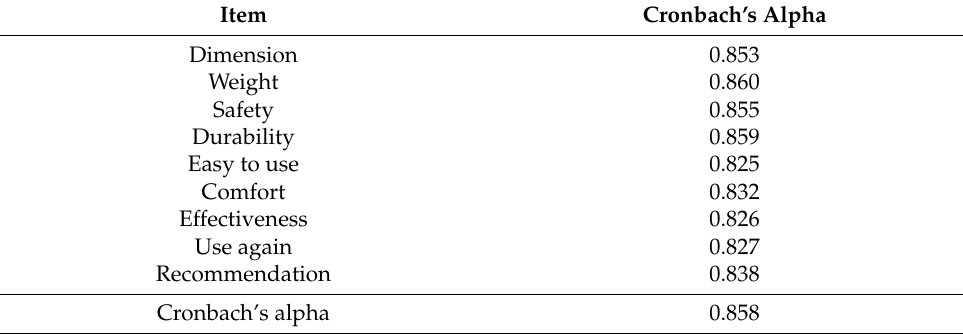
Table 7. Satisfaction evaluation item reliability assessment (Cronbach’s